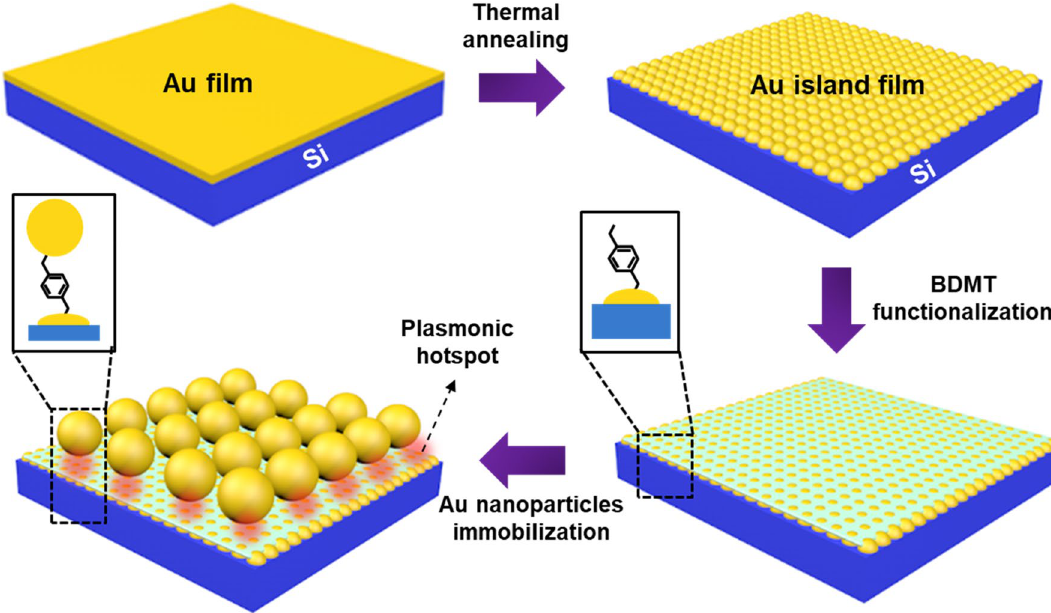
Figure 1. Schematic diagram of the fabrication process for AuNPs@BDMT@AuIF. AuIF is made by thermal annealing of Au thin film, and AuNPs@BDMT@AuIF are fabricated through immobilization of AuNPs on